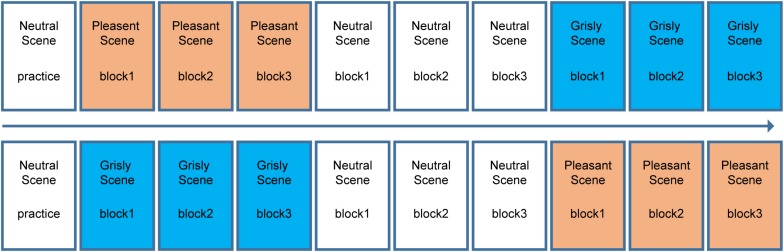
Block design for experiment 1. Top and bottom shows the block order for each half of the participants.